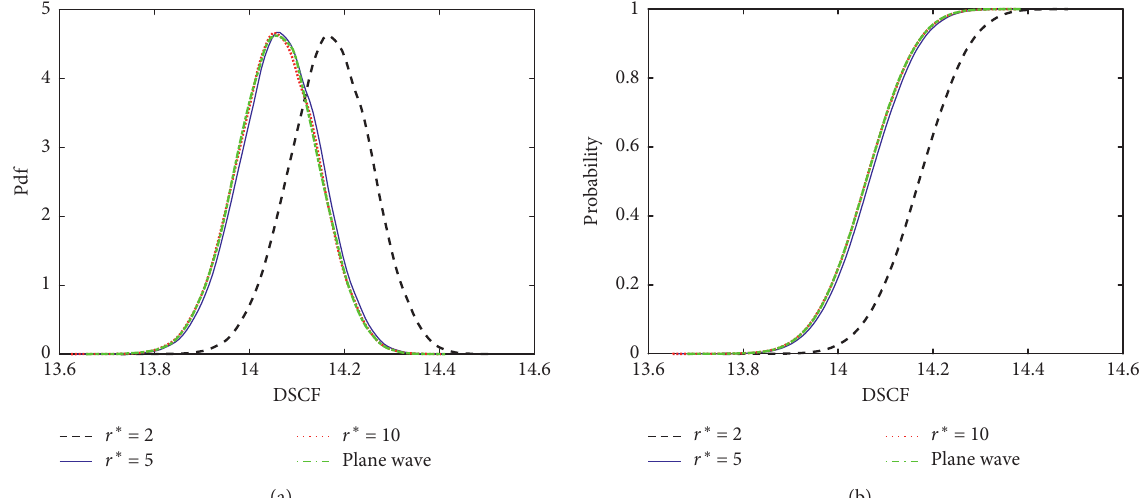
Figure 3: Mean and standard deviation of DSCF for different values of r ∗ : (a) mean ( δ ( δ G � 0.2); (d) standard deviation ( δ G �